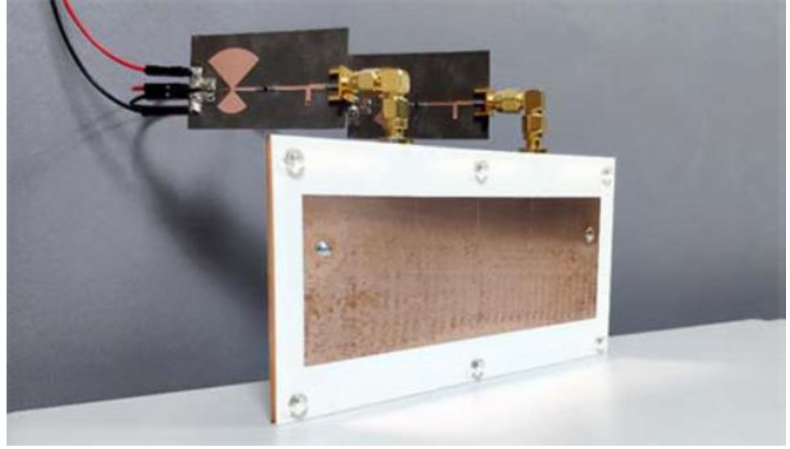
Figure 7. Photographs of the fabricated Rectenna